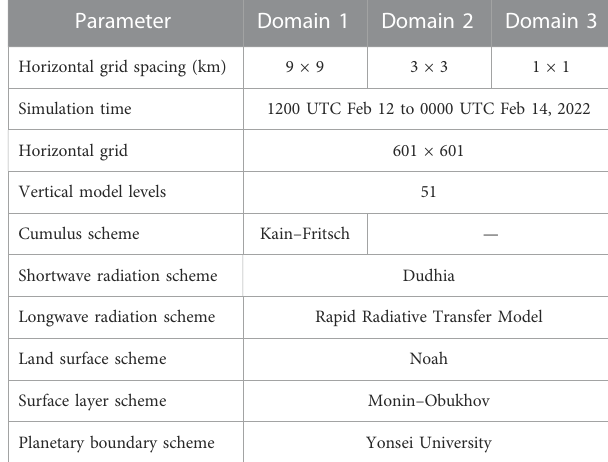
TABLE 1 Setup of model